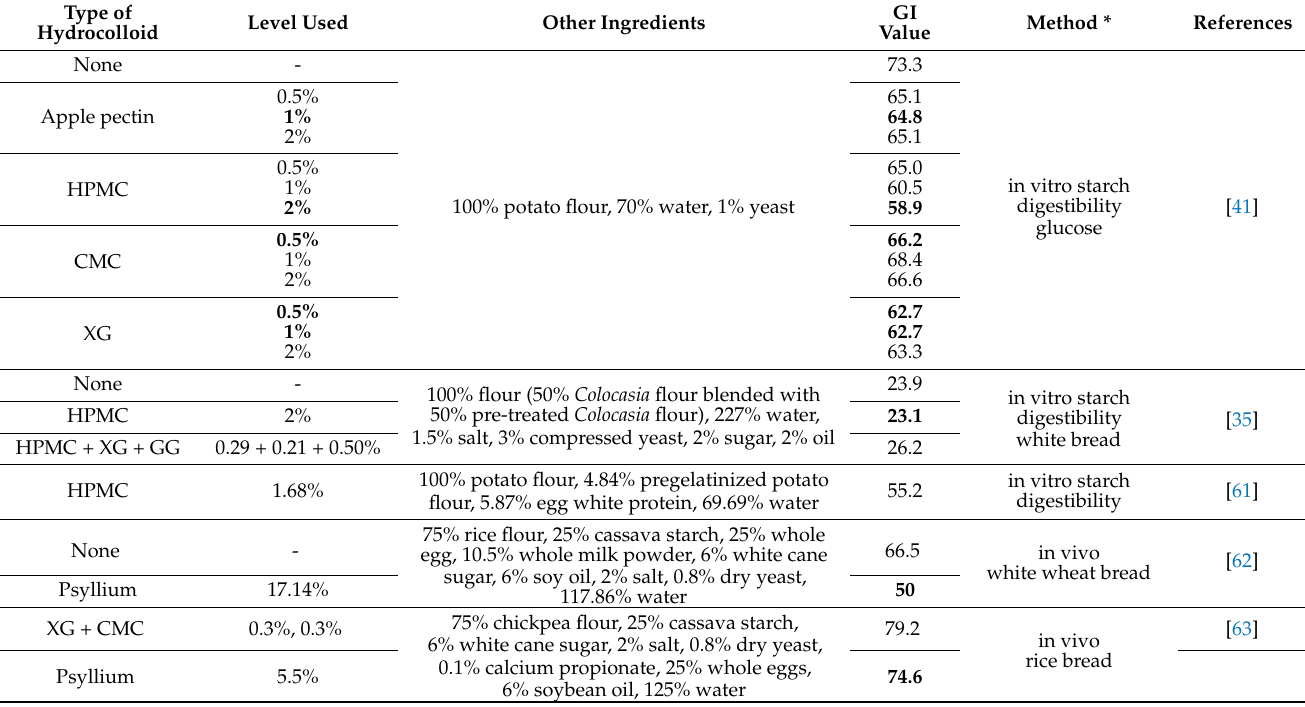
Table 4. Glycemic index for GF bread containing